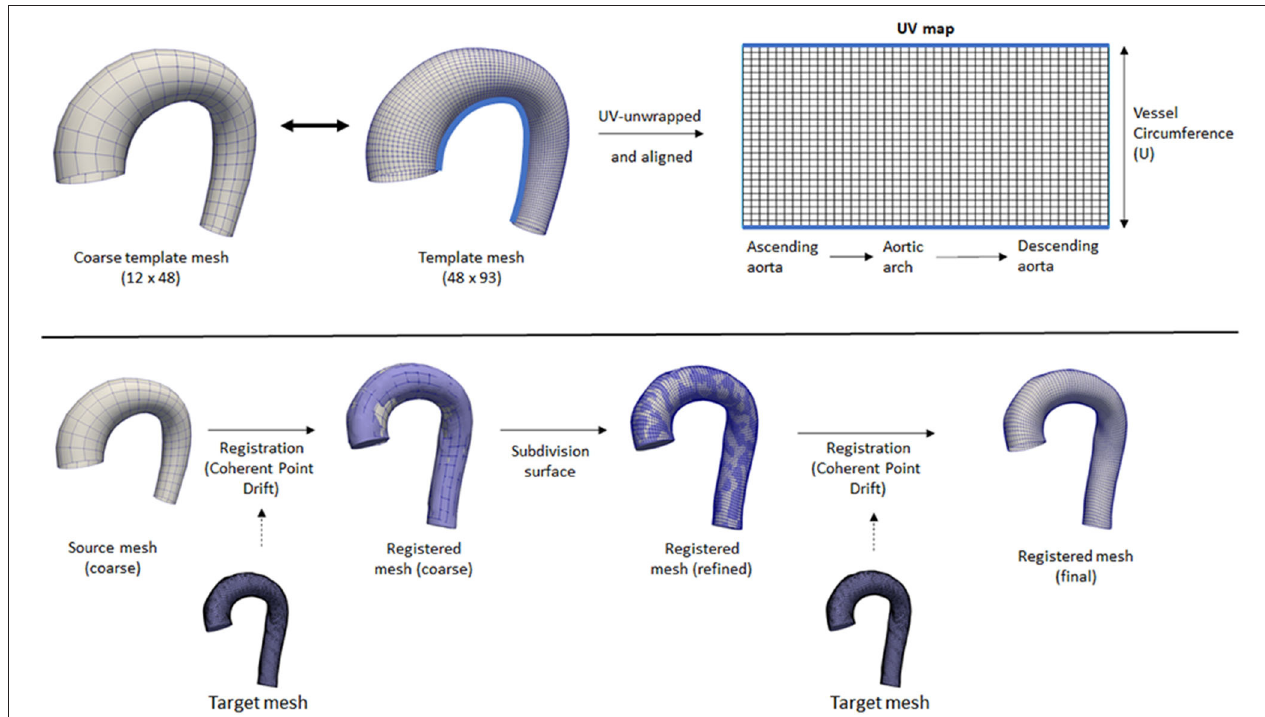
FIGURE 2 | Top: Coarse and fine template meshes used for registration. UV unwrapping was performed on the fine template mesh, with a light blue line showing the cut line. Bottom: An overview of the registration process using Coherent Point Drift. Registration was performed on the coarse template mesh, followed by a subdivision surface operation, followed by another registration step on the refined